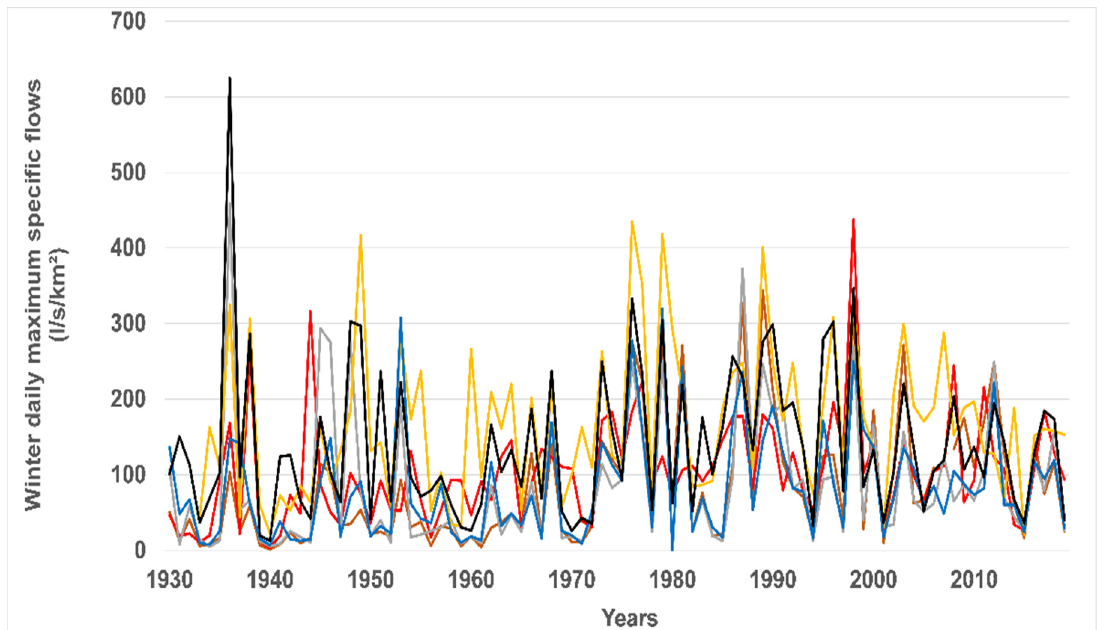
Figure 3. Interannual variability of winter daily maximum specific flows (l/s/km²) in the Southeast- ern hydroclimatic region from 1930 to 2019. Châteaugay River: red curve; Eaton River: yellow curve; Nicolet River: black curve; Etchemin River: blue curve; Beaurivage River: orange curve; Du Sud River: grey curve.